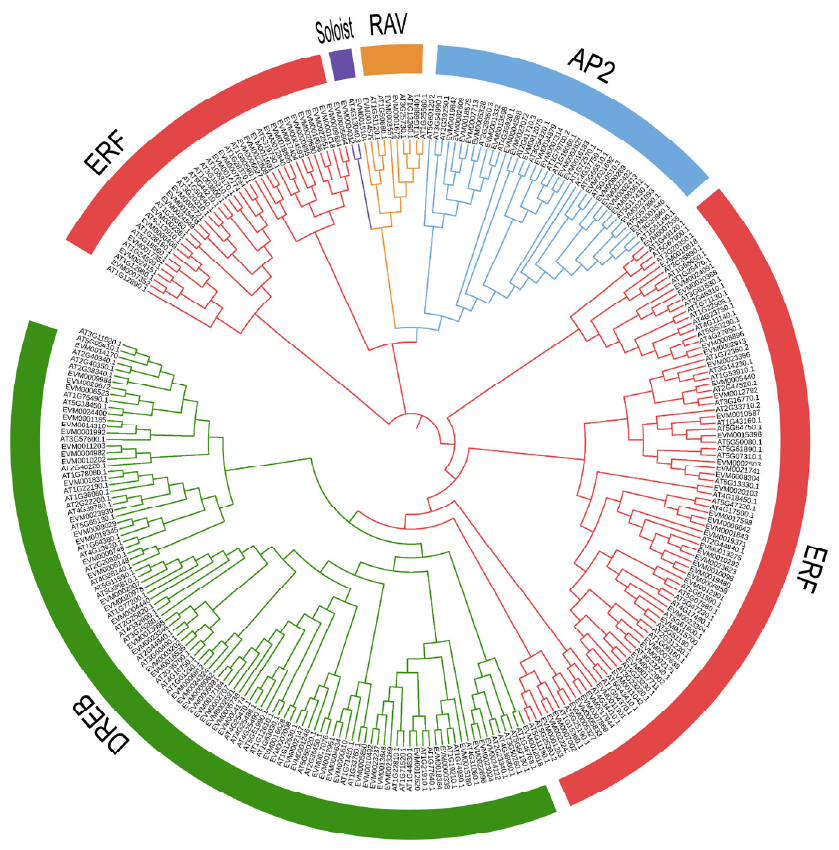
Figure 1. Phylogenetic tree of AP2/ERF genes between X. sorbifolium and A. thalian . The ERF, DREB, AP2, RAV, and Soloist families are distinguished by different colors.